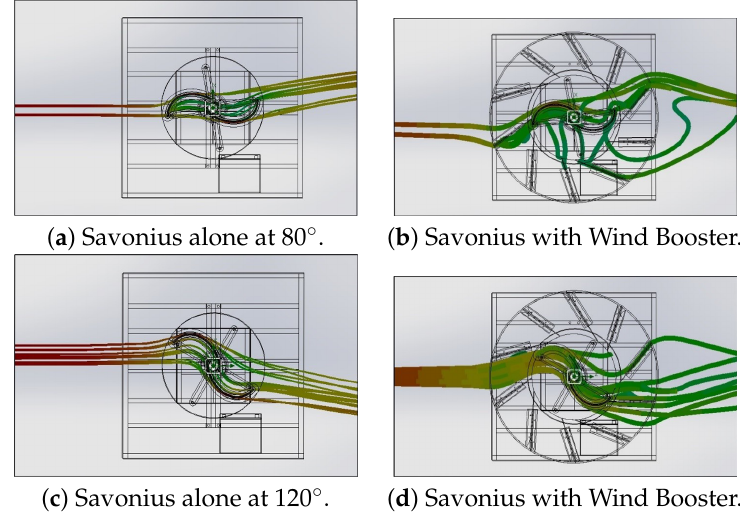
Figure 13. Wind Flow behavior at 2.04 m/s.